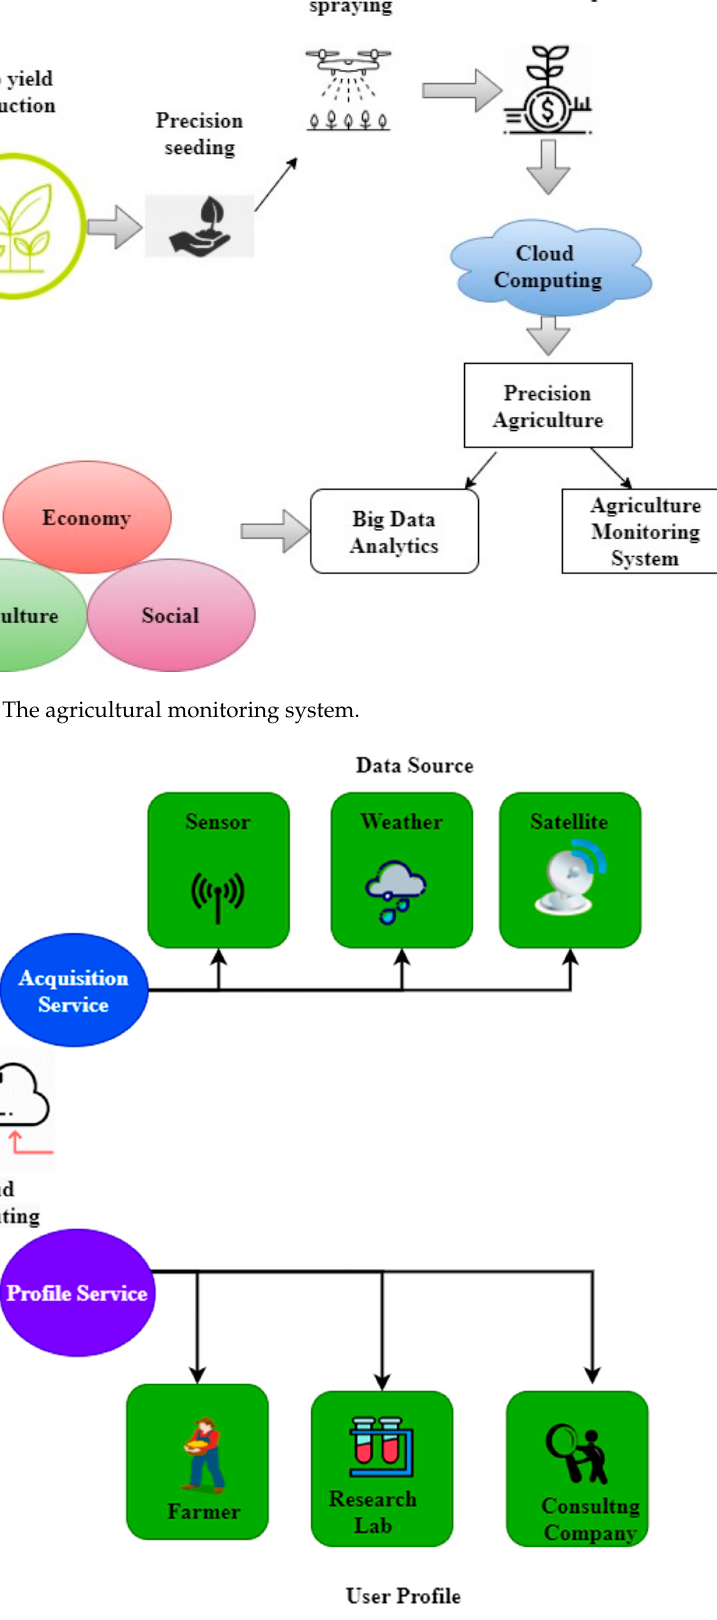
Figure 2. Cloud computing-based precision agriculture.